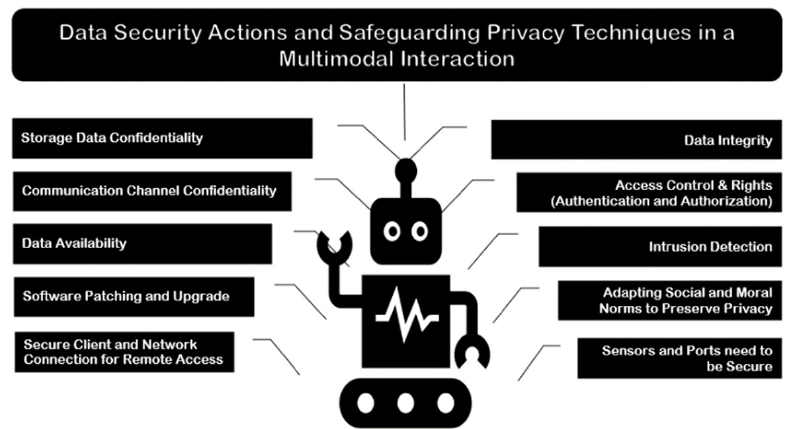
Figure 6. Security Measures for Safeguarding and Protecting User’s Data and